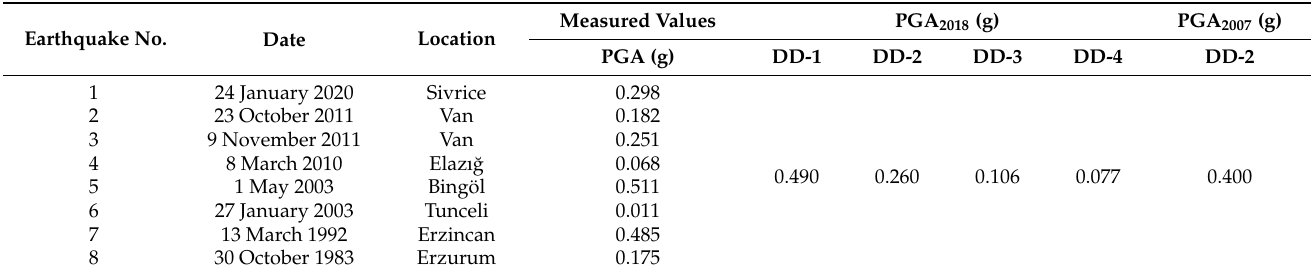
Table 7. Comparison of measured and obtained PGAs for minaret location.